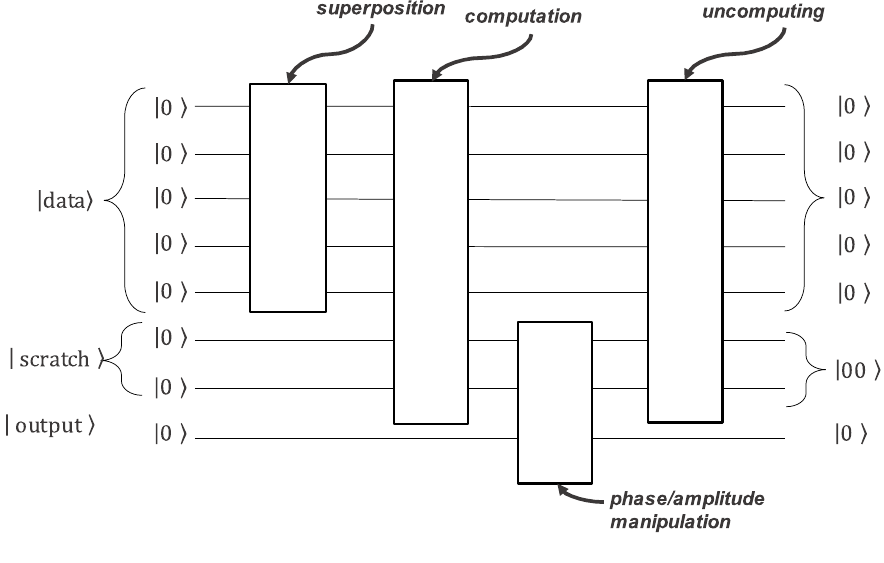
Figure 6. General scheme for a reusable module.